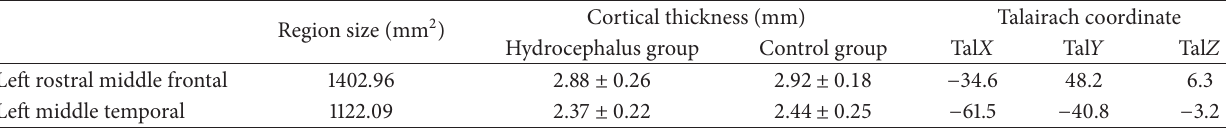
Table 2: Changes in cortical thickness in hydrocephalus patients.